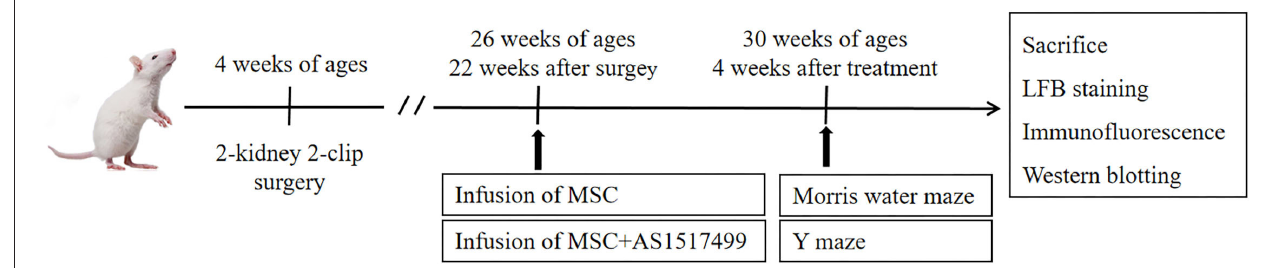
FIGURE 1 | Experimental protocol. Rats received surgery at the age of 4 weeks to establish RHRSP animal model. 22 weeks after the surgery, intervention treatment was applied. Morris water maze and Y maze were performed after 4 weeks of intervention treatment and then rats were